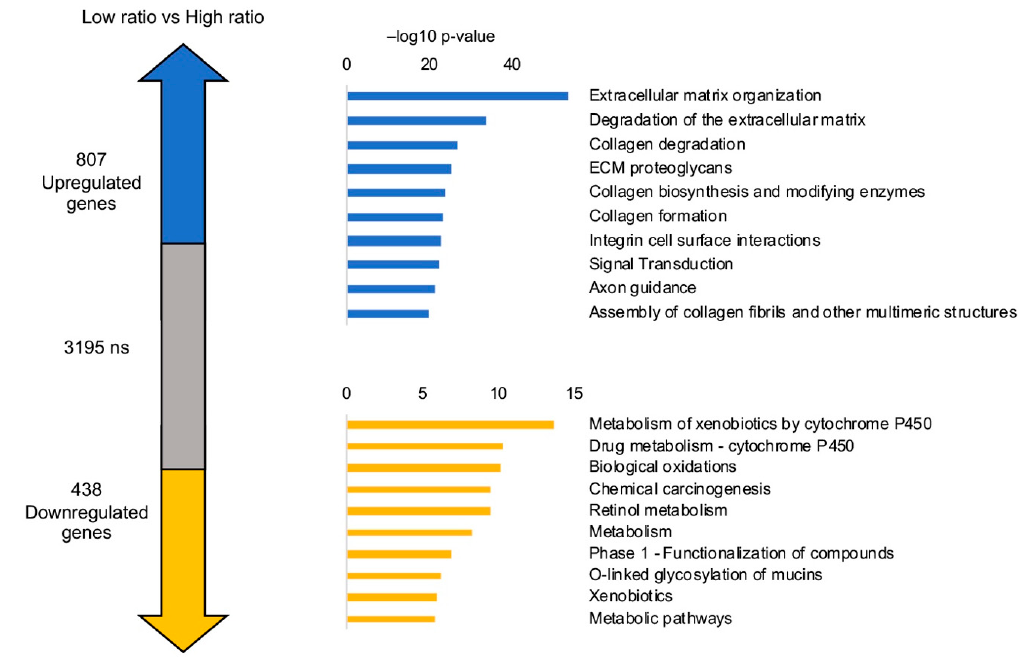
Figure 9. DEG analysis of 80 tumors with low NF-YAs / NF-YAl ratio. The number of up- and down-regulated genes in the comparison between tumors with low and high NF-YAs / NF-YAl ratios, as in Figure 8. Right panels, Reactome pathways enriched in up-regulated (upper panel) and down-regulated (lower panel) genes in low vs. high NF-YAs / NF-YAl ratios, listed according to their p-value. The list is obtained using KOBAS.